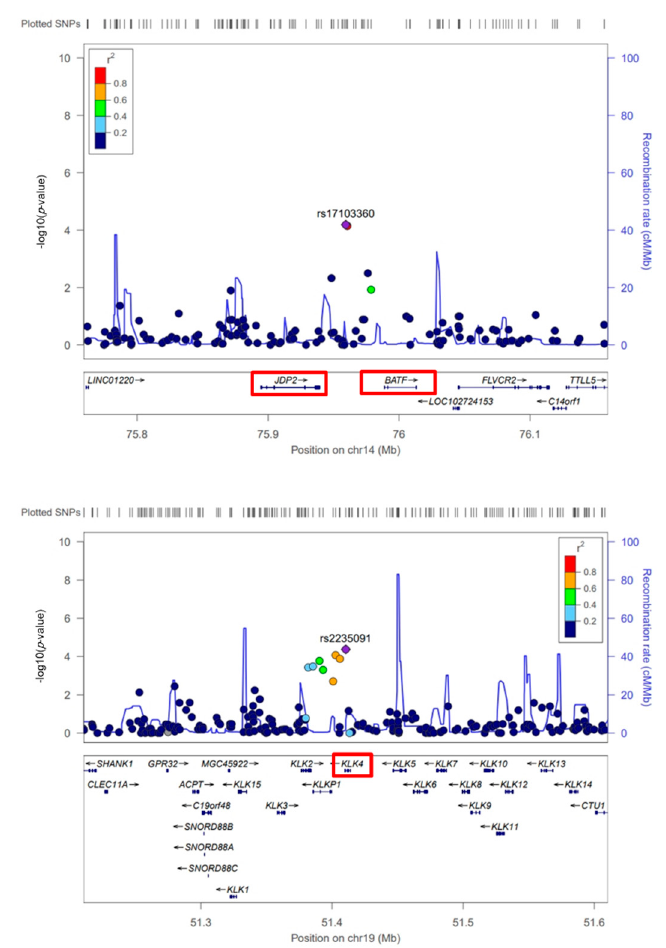
Figure 2. Illustration of association signals from strong linkage disequilibrium (LD) showed loci (top: JDP2 and BATF gene loci on chromosome 14; bottom: KLK4 gene locus on chromosome 19). Red boxes indicate the nearest genes with associated single nucleotide polymorphisms (SNPs). The diagram was visualized by LocusZoom (http://locuszoom.org/). AX-1282496: rs17103360; AX-12824299: rs7155418; AX-86334747: rs7155603; AX-40466275: rs198977; AX-11665883: rs8103659; AX-32775669: rs198956; AX-96079990: rs1354774; AX-11280320: rs1654513; AX-11663123: rs8103659; AX-40466329: rs2235091. The color indicates values of LD.